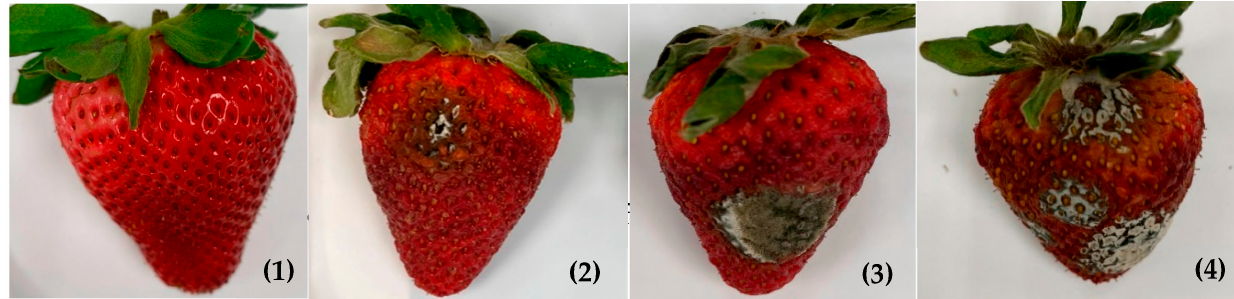
Figure 1. Gray mold disease rating scores ( 1 – 4 ) of strawberry fruit.